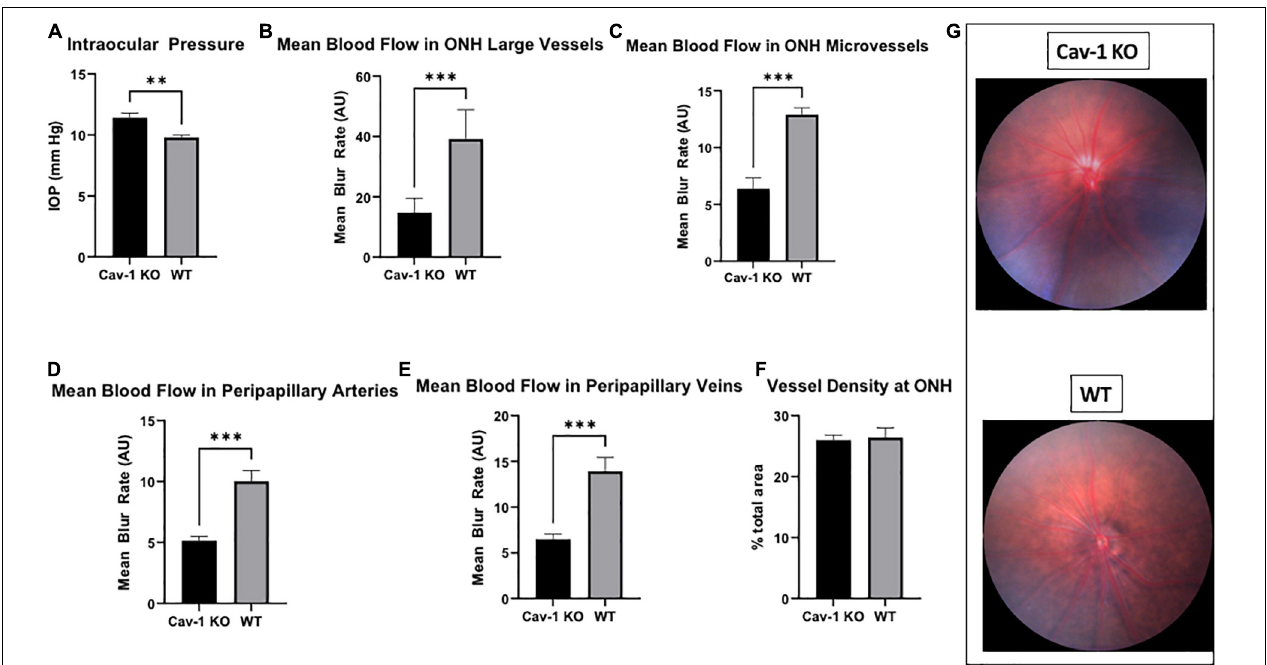
FIGURE 1 | Intraocular pressure and optic nerve head characteristics in Cav-1 KO and WT mice. (A) Cav-1 KO mice show significantly higher IOP than WT. (B–E) Mean blood flow in optic nerve head and peripapillary vessels is lower in Cav-1 KO compared to WT mice. (F) Vessel density at the optic nerve head is not significantly different. (G) Colored fundus photographs do not show obvious differences in optic nerve head and peripapillary vessel morphology, ** p < 0.01, *** p < 0.001.